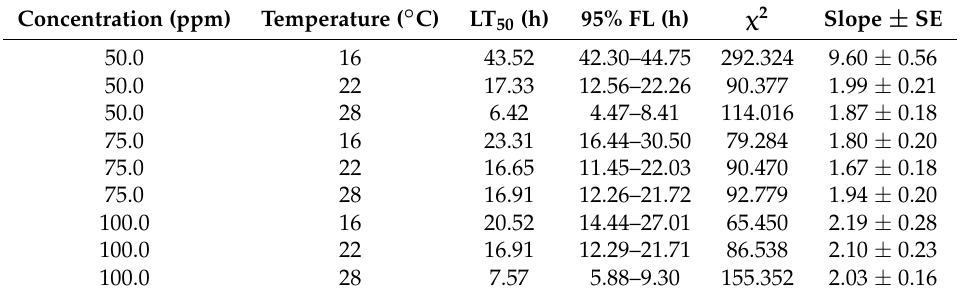
Table 3. Effect of concentration and temperature on mortality of eastern subterranean termites, R. flavipes , exposed to indoxacarb.